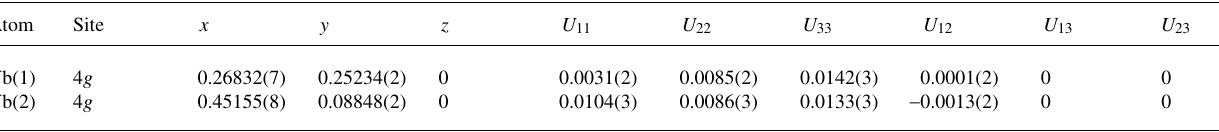
Table 2. Atomic coordinates and displacement parameters (in Å 2 )